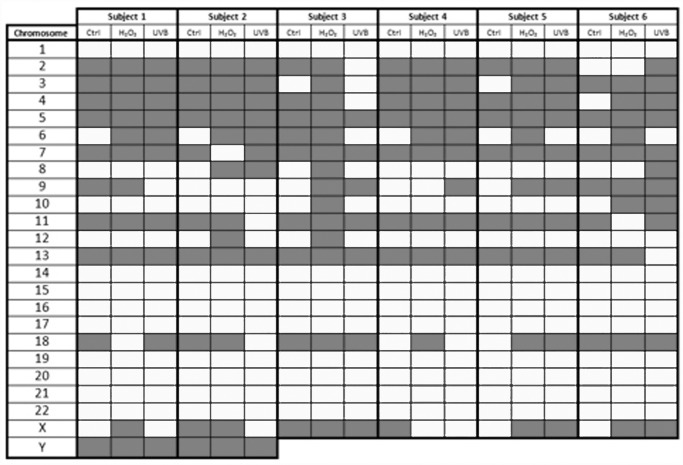
Non-random or random chromosome position status for all subjects and conditions.Each colored block represents the status of the chromosome position for all six subjects and three tested conditions following analysis of 100 cells. Chromosome territory position was determined to be random or non-random by the χ2 goodness of fit test (df:4). White blocks indicate non-random positioning (p<0.05), whereas grey blocks indicates random positioning. Data for chromosome Y is provided only for the two male subjects. The control (unexposed) condition is abbreviated in the table (Ctrl).